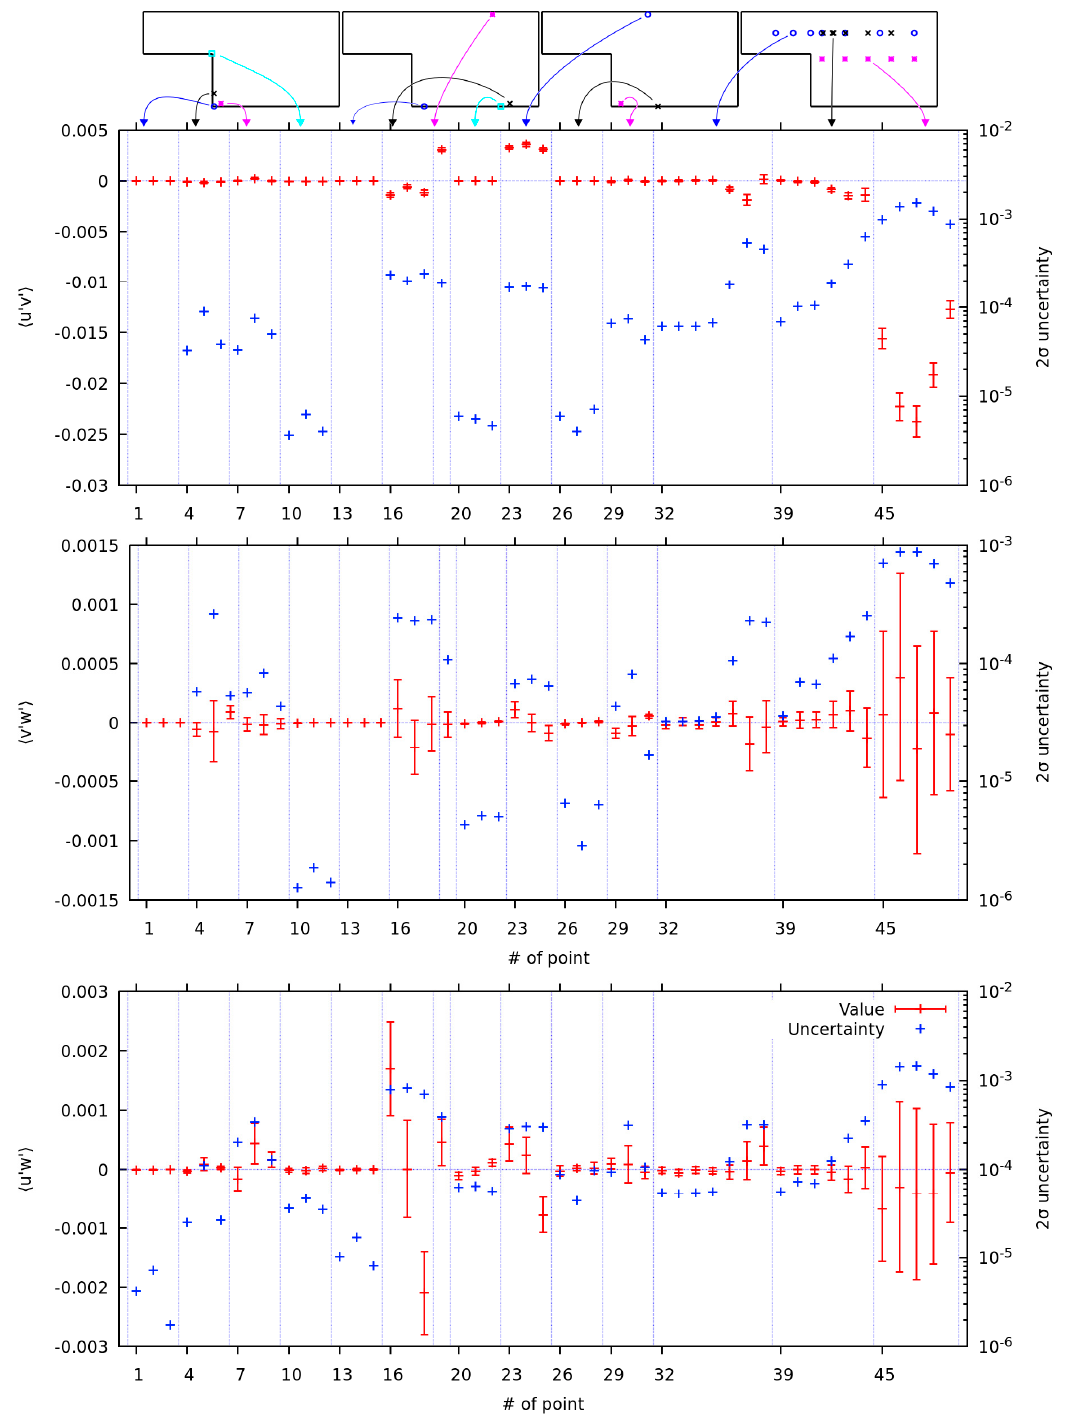
Figure A1. x -axis: number of point according to Figure 2. Top to bottom: Reynolds stress components (cid:104) u (cid:48) v (cid:48) (cid:105) , (cid:104) v (cid:48) w (cid:48) (cid:105) and (cid:104) u (cid:48) w (cid:48) (cid:105) . Red dots represent root-mean-square values with ± 2 σ range (left scale), green dots represent (2 σ ) uncertainty (right scale).